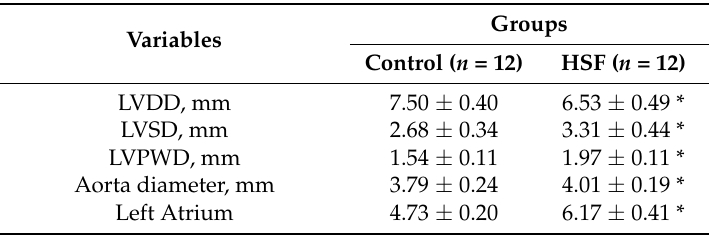
Table 3. Effect of HSF diet on hemodynamic and cardiac remodeling.